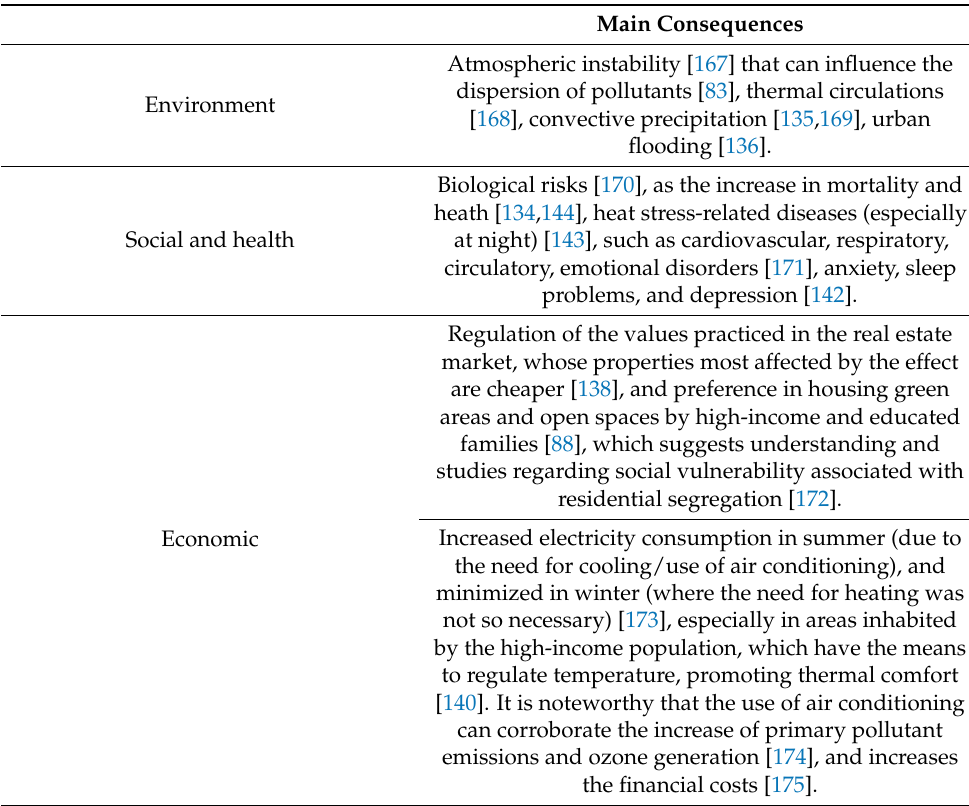
Table 15. Main consequences of the UHI and SUHI